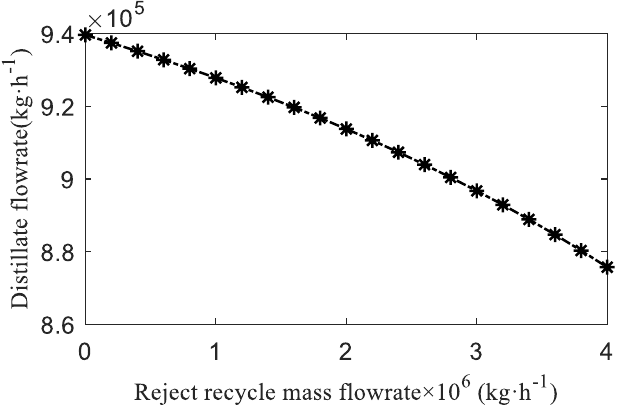
Figure 7. E ff ect of reject recycle mass flowrate ( S ) on distillate flowrate ( W DN ). Figure 7. Effect of reject recycle mass flowrate ( S ) on distillate flowrate ( DN W ).